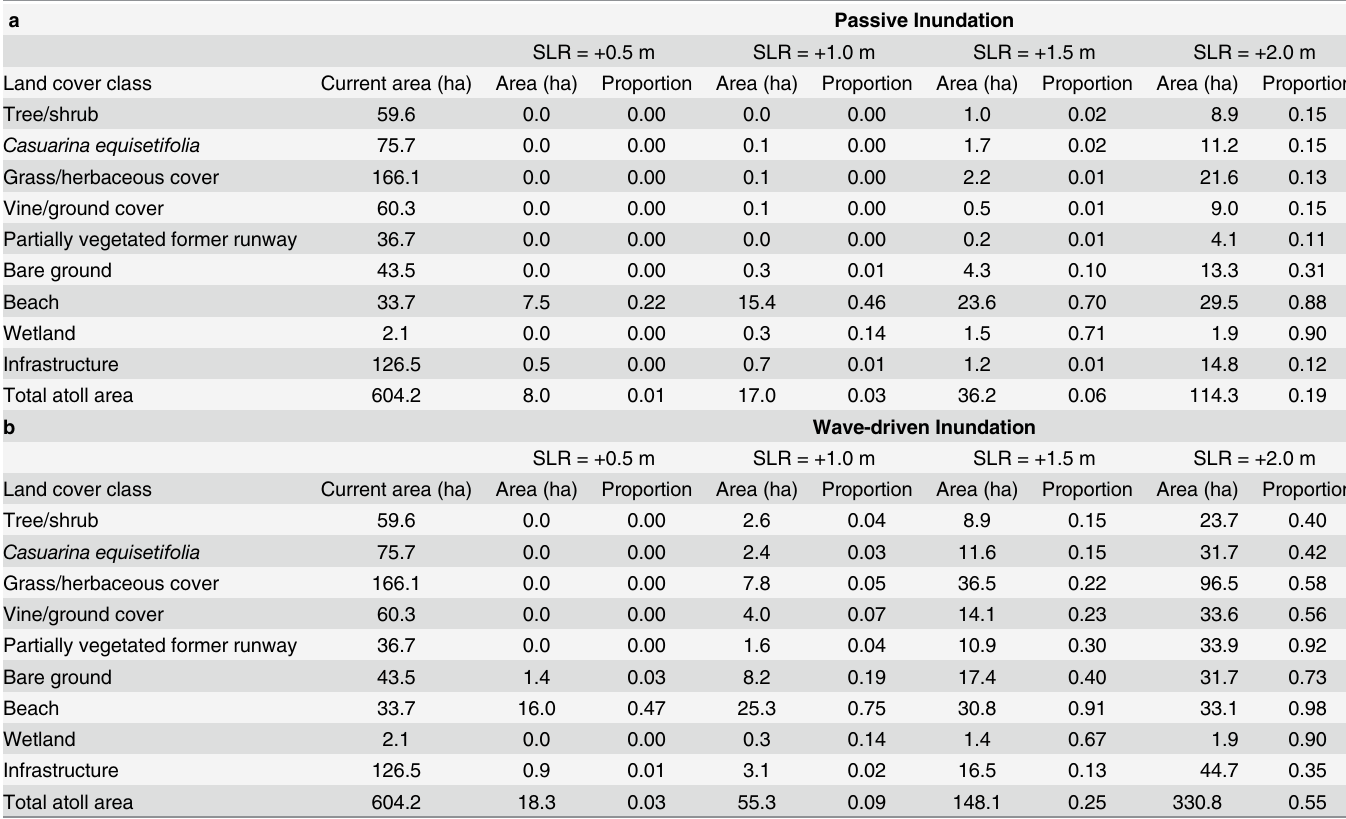
Table 3. The projected area inundated (in hectares as a proportion of land cover class, or total island area) at Midway Atoll for four scenarios of sea-level rise and two modeling approaches, passive (a) and wave-driven (b), with effects of rising groundwater.